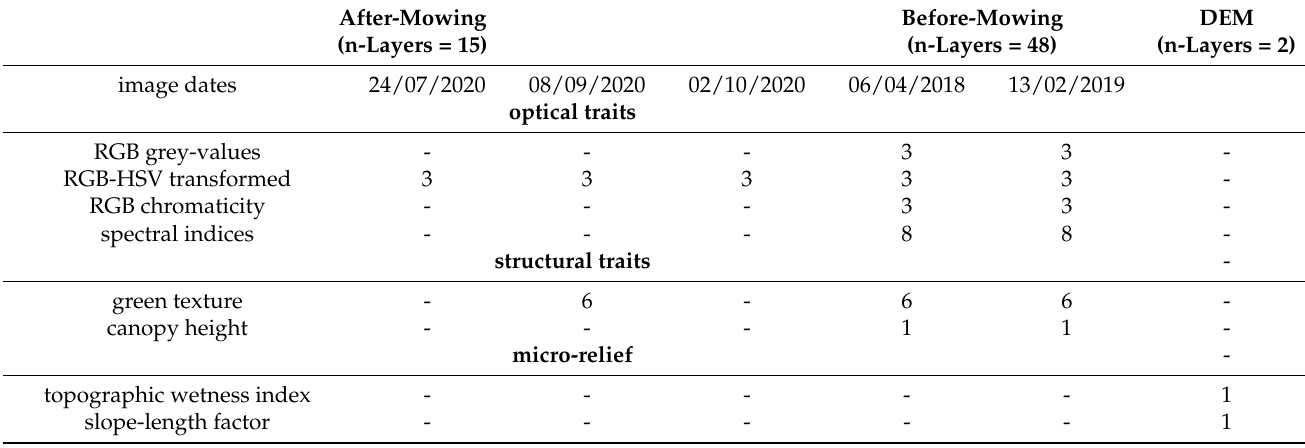
Table 1. Matrix of predictor variables derived as image layers to calibrate after-mowing classification and perform regression analysis in before-mowing images; predictors can be grouped into representing plant traits and relief-based indices. After-Mowing (n-Layers = 15)